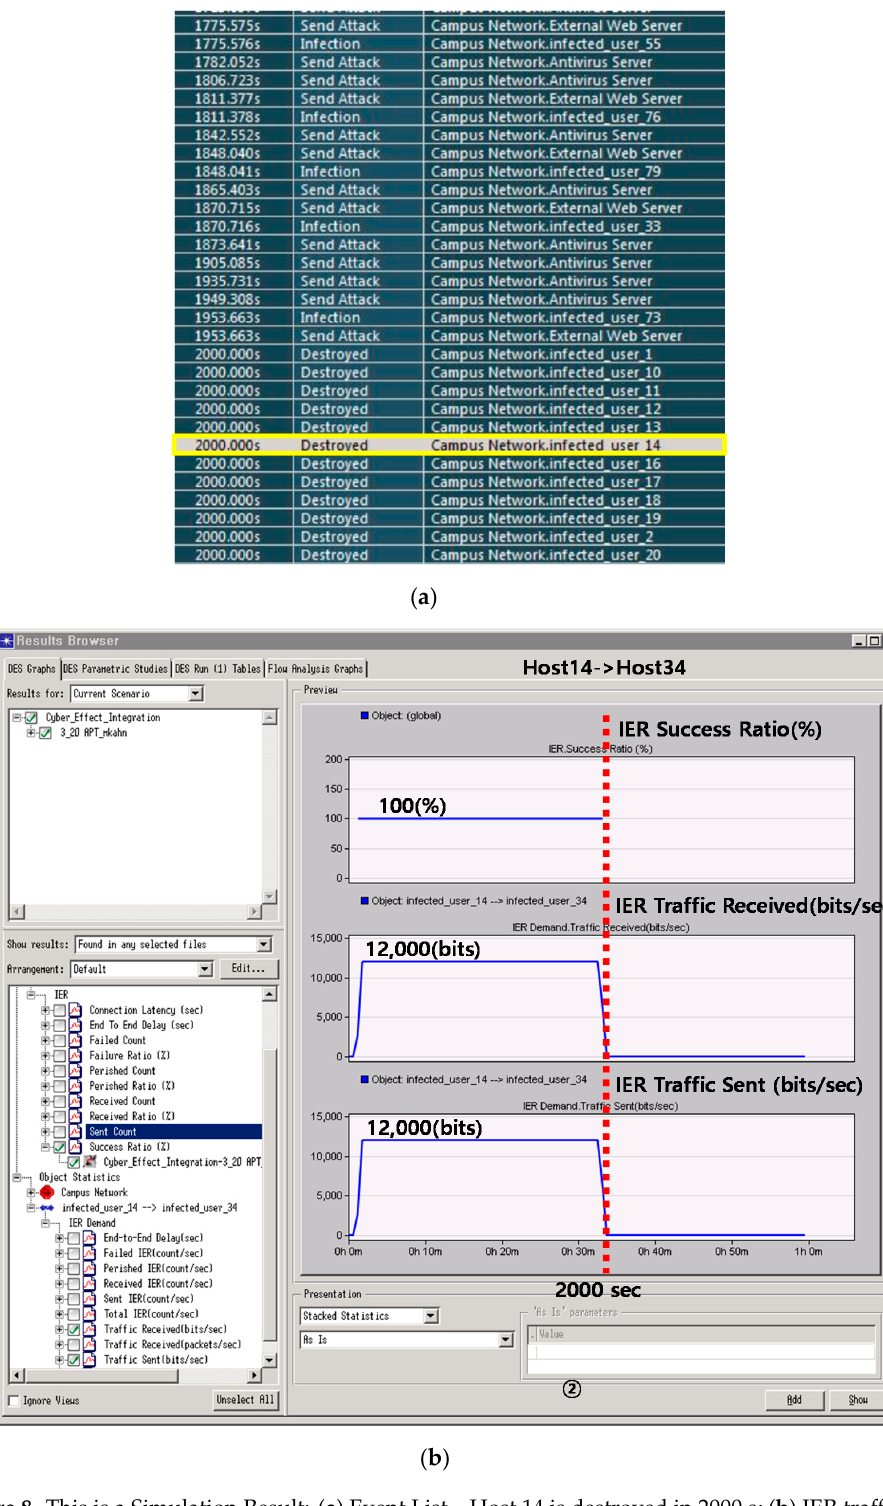
Figure 8. This is a Simulation Result: ( a ) Event List—Host 14 is destroyed in 2000 s; ( b ) IER traffic—As the Host 14 is destroyed in 2000 s, the message cannot be sent or received, and the success ratio is zero .